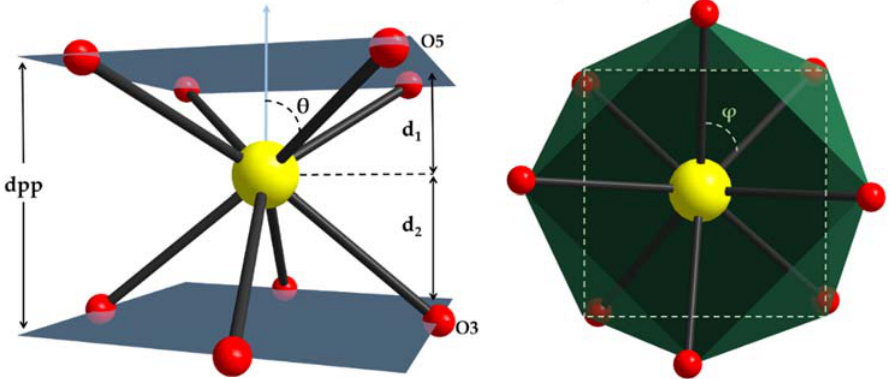
Figure 2. Details of structural parameters discussed in the text for complex 2 . Yellow ball: terbium, red ball: oxygen.